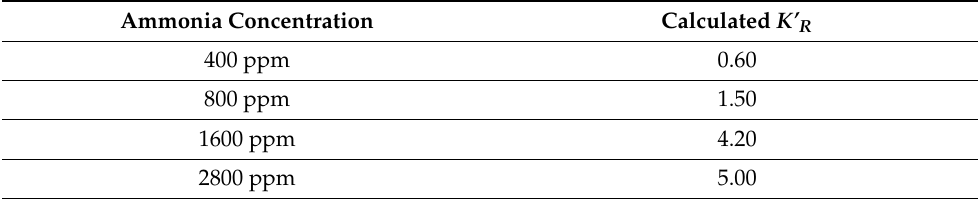
Figure A1. An exponential curve fitting was used to estimate/extrapolate the saturated dielectric response K’ R of zeolite Y at 3 GHz. Table A2. Calculated K’ R for different NH 3 concentrations at 3